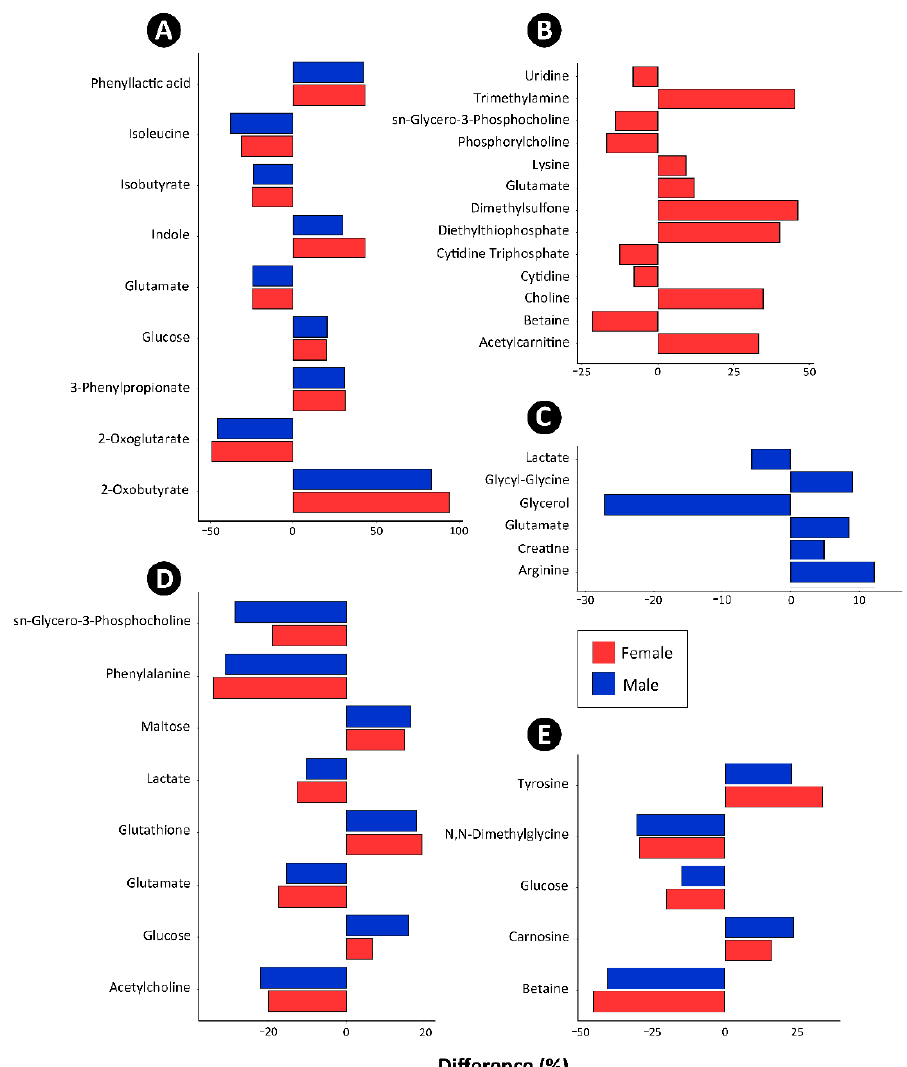
Figure 7. Average percent differences of individual metabolite quantities associated with female and male birds fed a diet supplemented with canola meal (20%) or a control diet as identified by a Mann-Whitney U test. All metabolites shown were significantly altered based on a p-value less than 0.05. ( A ) Cecal digesta. ( B ) Pancreas from female birds. ( C ) Pancreas from male birds ( D ) Liver. ( E ) Breast muscle. Negative values are less abundant, and positive values are more abundant in birds fed the canola meal diet.